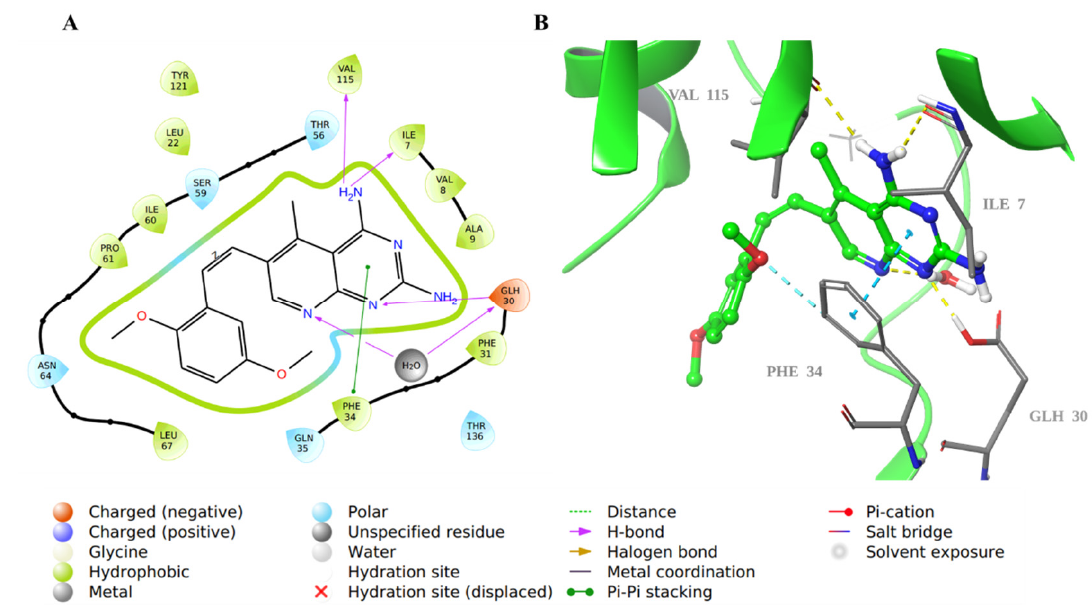
Figure 7. Molecular docking of co-crystallized inhibitor SRI-9662 in hDHFR (PDB: 1KMV). ( A ) 2D representation of binding interactions of SRI-9662 with amino acid residues in the active site within a 3 Å distance; ( B ) 3D representation of SRI-9662 in green within the hDHFR active site. The H-bond and aromatic-hydrogen interactions are in yellow and cyan dotted lines, respectively. A light blue dotted line represents the π - π stacking between aromatic rings.